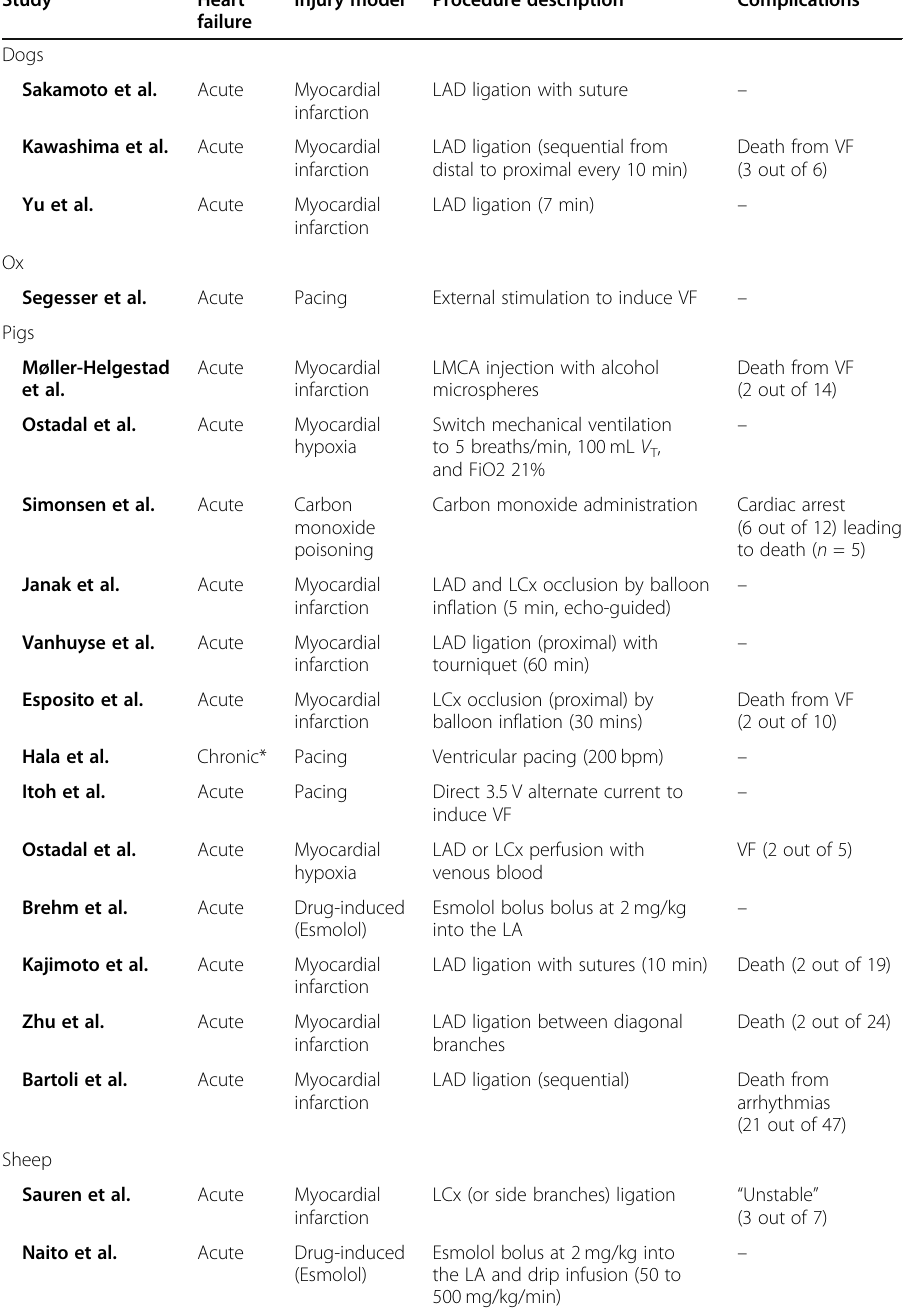
Table 3 Detailed characteristics of heart failure model